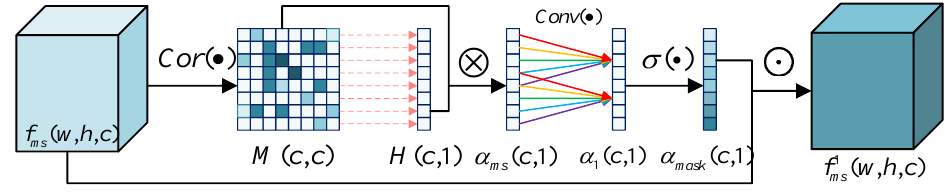
Figure 4. The proposed channel attention module (GCA-module) for MS